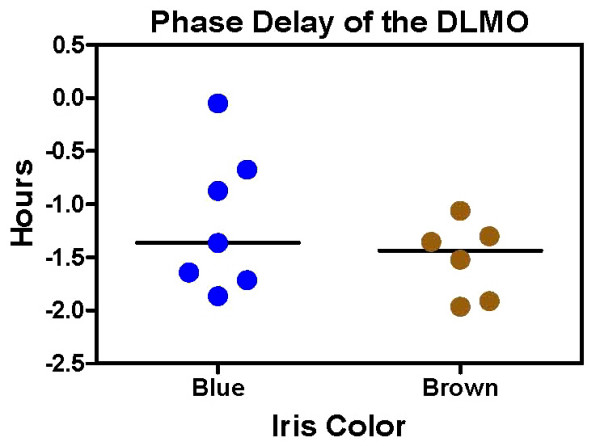
Circadian rhythm phase delays with a single bright light pulse and delayed sleep/dark episode. The horizontal lines represent the median phase delays.